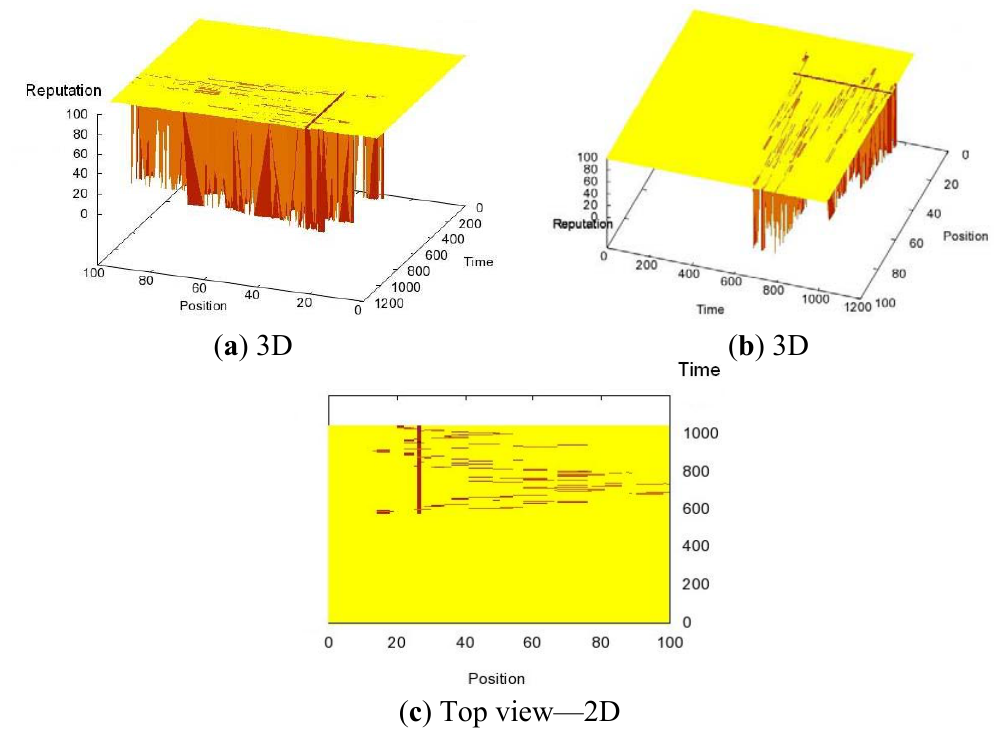
Figure 2. Reputation Evolution in Time and Space—Different Views.